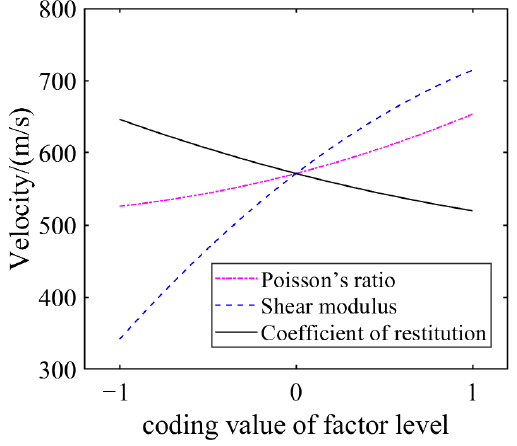
Figure 8. Curves of various factors on the velocity.